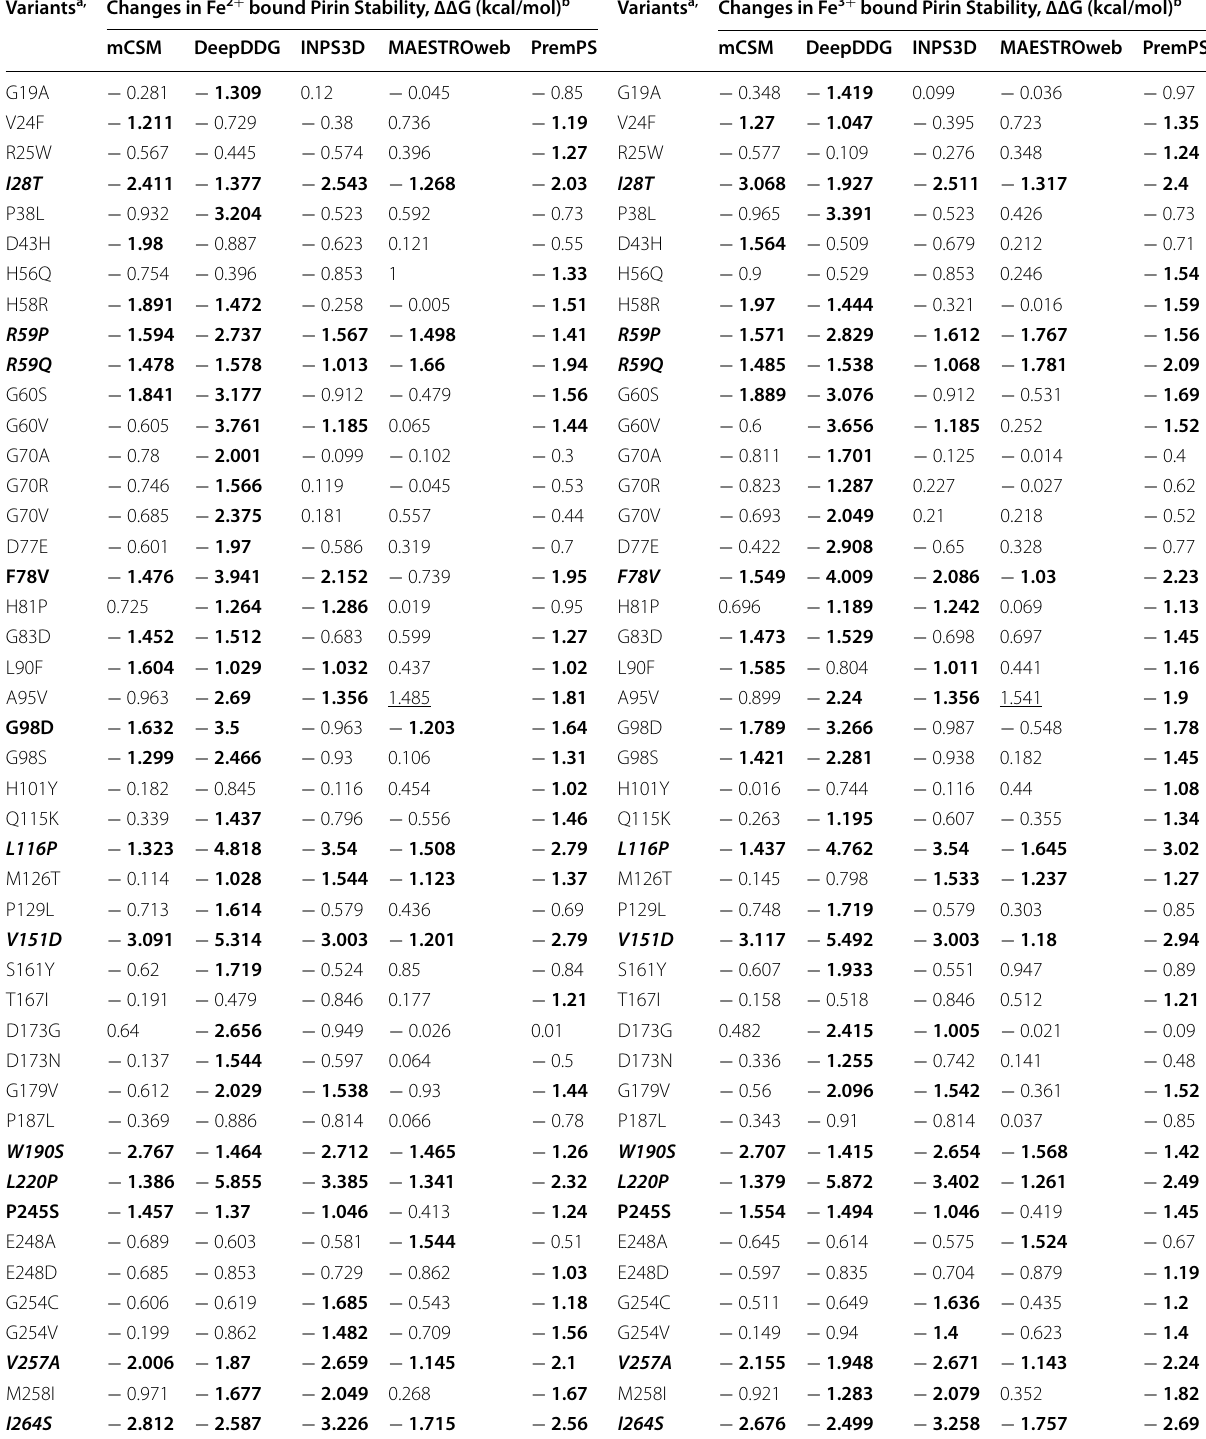
Table 2 Impacts of potentially pathogenic missense variants on pirin